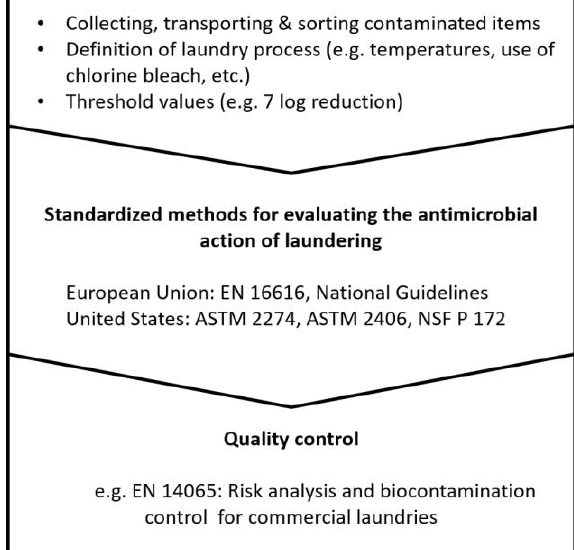
FIGURE 2: Defining and controlling laundry hygiene in health care